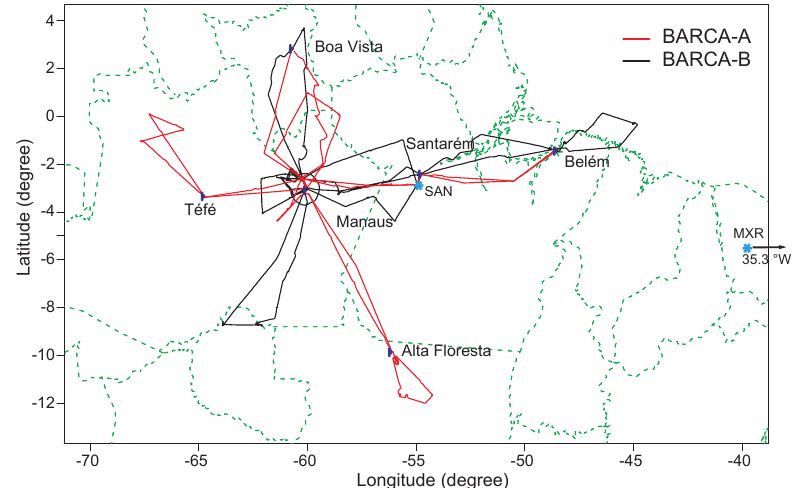
Fig. 1. Flight tracks of the BARCA aircraft campaigns (red: BARCA-A, black: BARCA-B). The ground measurement sites SAN and MXR are indicated by blue